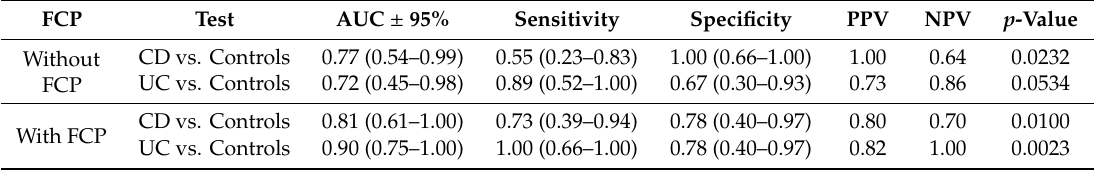
Table 9. CD vs. Controls & UC vs. Controls (without and with FCP): Wolf eNose results. FCP